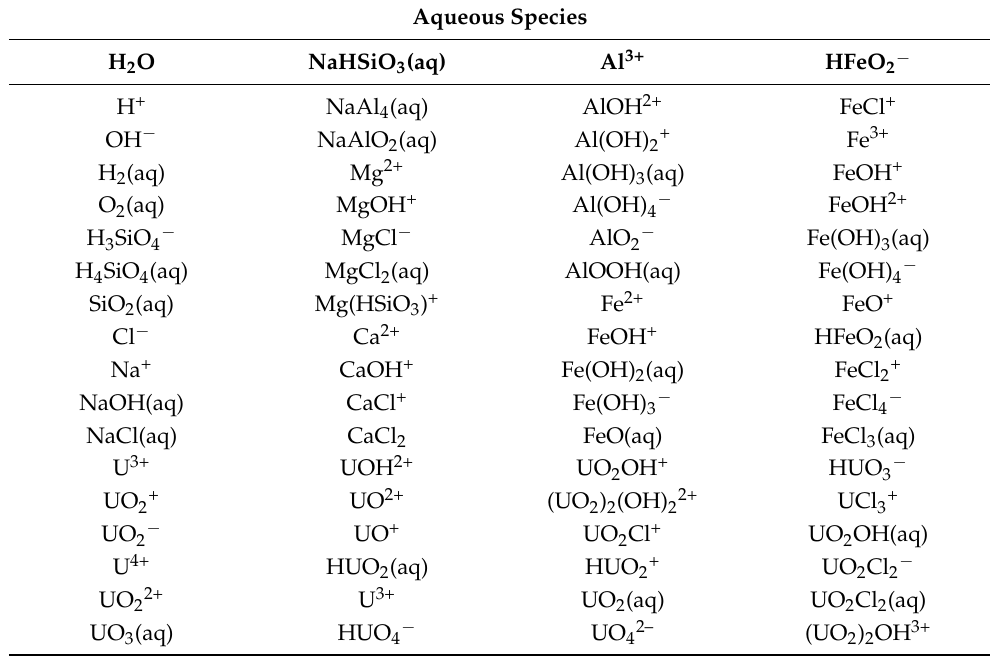
Table A1. The aqueous species included in the modeling of altered marine